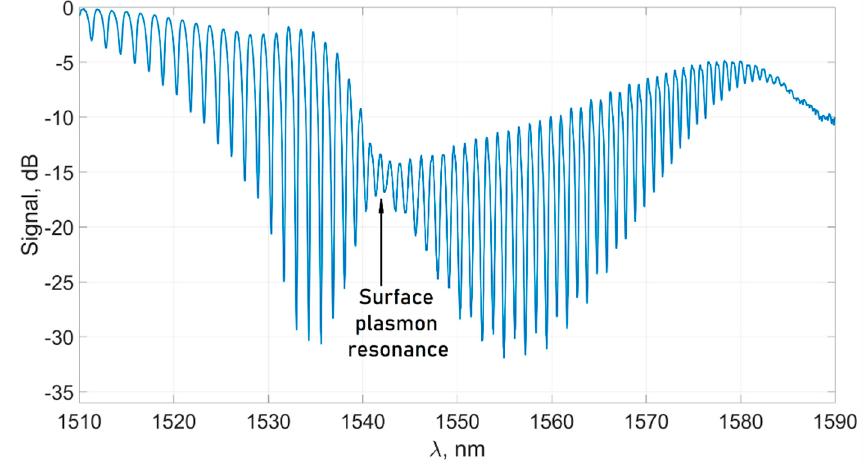
Figure 3. Typical transmission spectrum of the plasmon TFBG-assisted sensor.